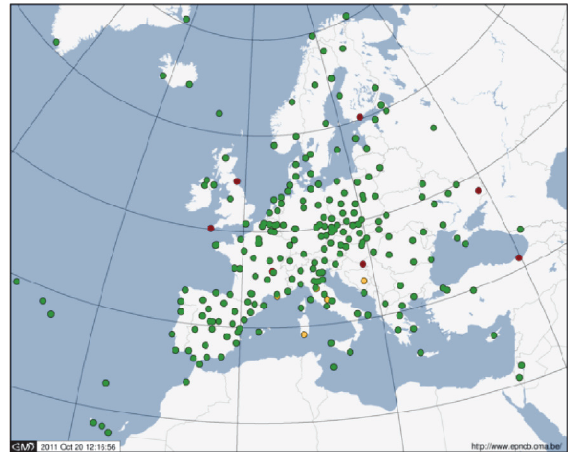
Fig 1. EUREF Permanent Network (EUREF...